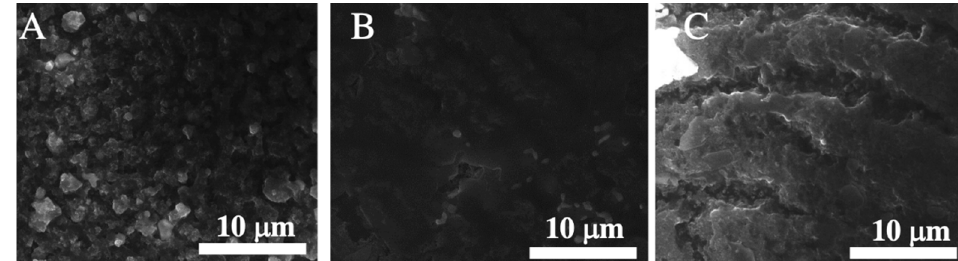
Figure 8. SEM images of samples after immersion in SBF solution. ( A ) Produced by laser frequency of 600 kHz and immersed in SBF for 4 days; ( B ) produced by laser frequency of 800 kHz and immersed in SBF for 4 days and ( C ) produced by laser frequency of 1200 kHz and immersed in SBF for 4 days.